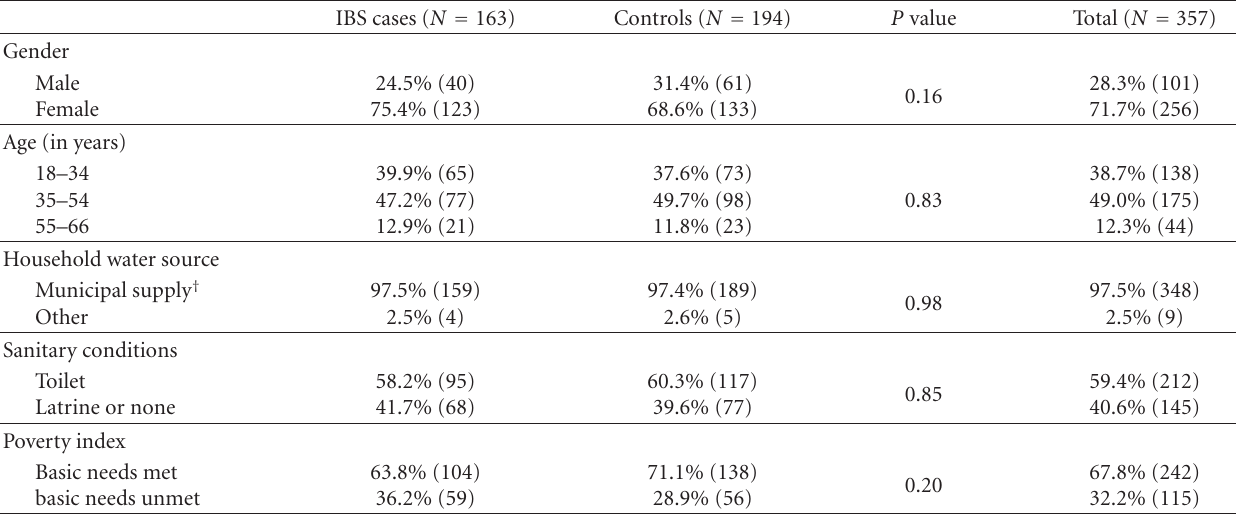
Table 1: Summary of the study